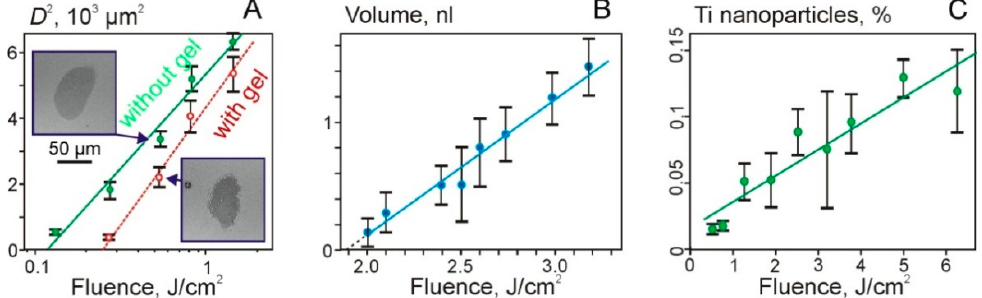
Figure 4. Dependences of the square of the hole diameter in Ti film ( A ), the volume of the transferred gel microdroplets ( B ), and the percentage of TiNP in microdroplets on the laser fluence ( C ). Figure 4A shows values for the Ti film with and without a gel layer (empty red circles). Examples of SEM images of holes for F = 540 mJ/cm 2 are also shown.